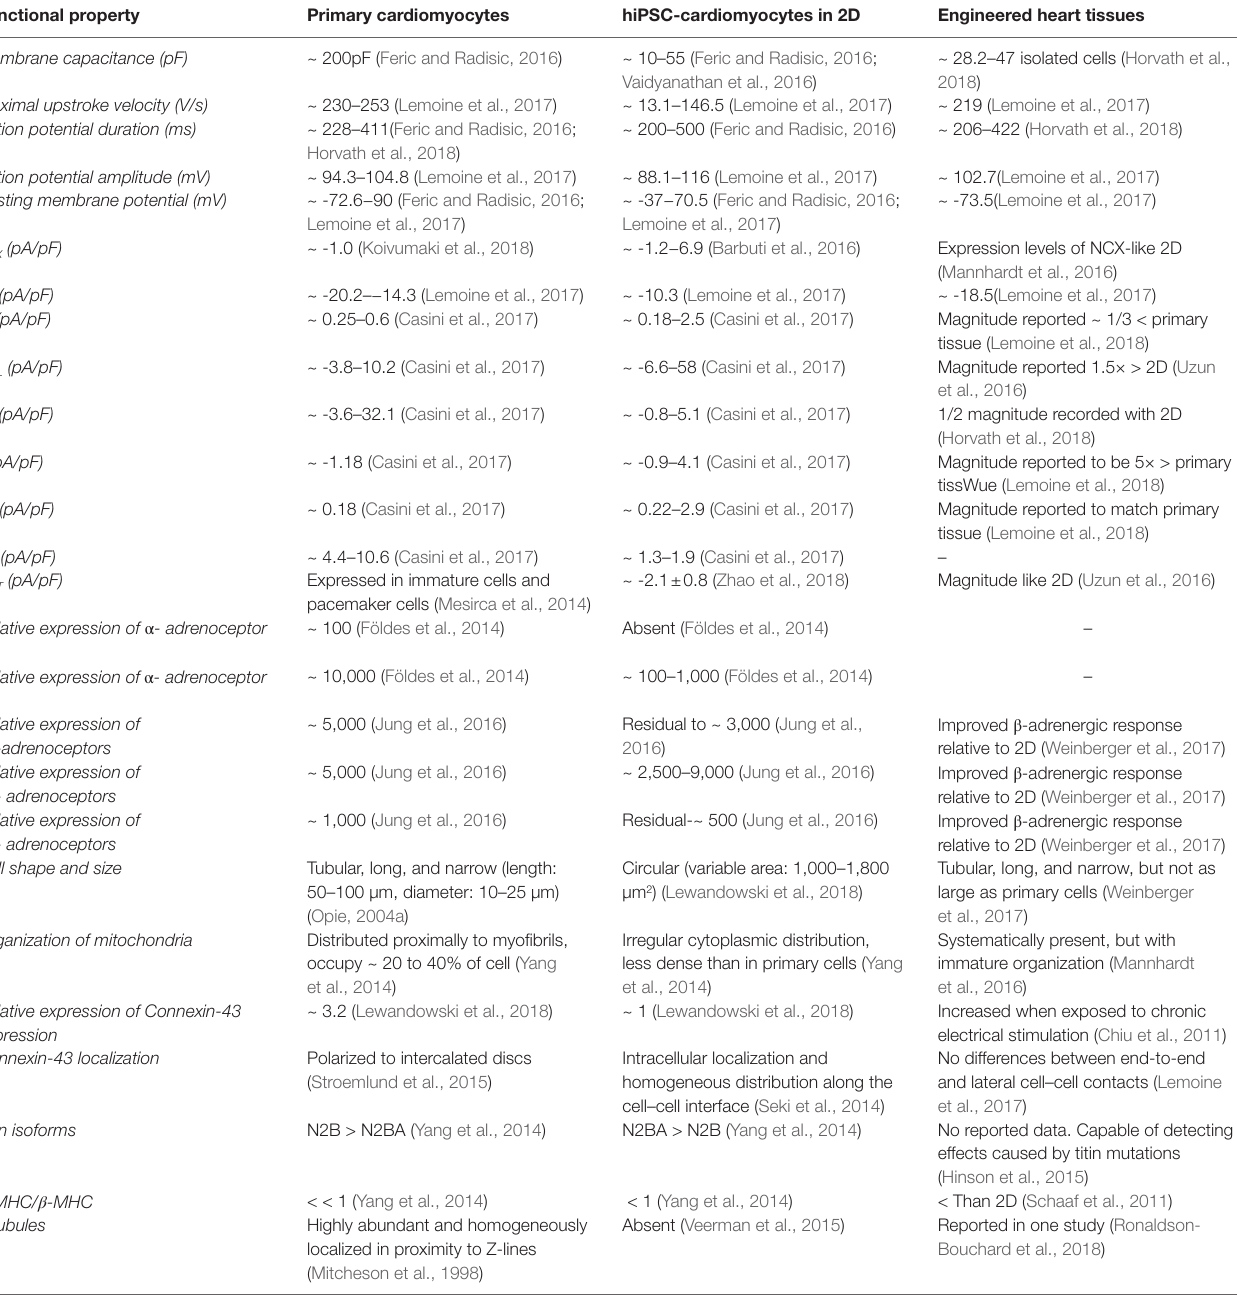
TABLE 2 | Experimentally obtained properties related to specific levels of cardiomyocyte function that can affect contractility or cellular effects of compounds. The values of properties have been published and are presented for primary cardiomyocytes, hiPSC-cardiomyocytes in 2D, and engineered heart tissues. I generally represents the current density of different regulators of electrophysiological function: sodium-calcium exchange current (I NCX ), sodium current (I Na ), rapidly activating component of the rectifier potassium current (I Kr ), L-type calcium current (I Ca,L ), inward rectifier potassium current (I K1 ), “funny” current (I f ), slowly activating component of the delayed rectifier potassium current (I KS ), calcium-insensitive transient outward current (I to1 ), and T-type calcium current (I Ca,T ). MHC represents myosin-heavy chain, which affects the physiological relevance of